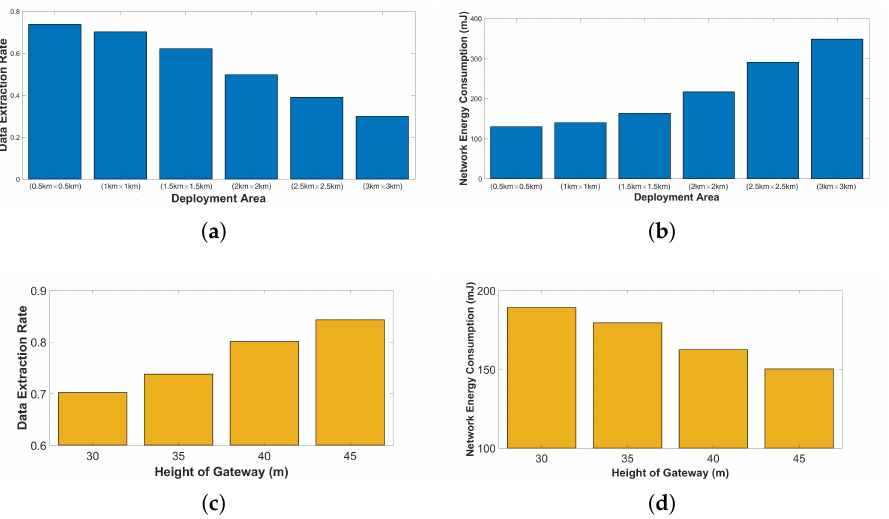
Figure 6. Okumura–Hata path loss model in an urban environment: ( a ) DER as a function of the size of the deployment area; ( b ) NEC as a function of the size of the deployment area; ( c ) DER relative to the height of gateway; and ( d ) NEC relative to the height of